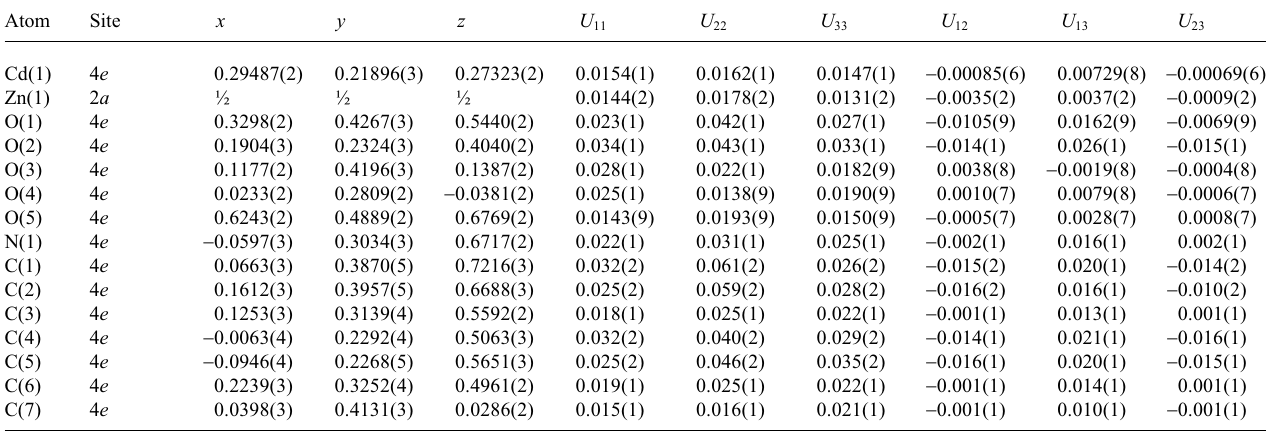
Table 3. Atomic coordinates and displacement parameters (in Å 2 ).